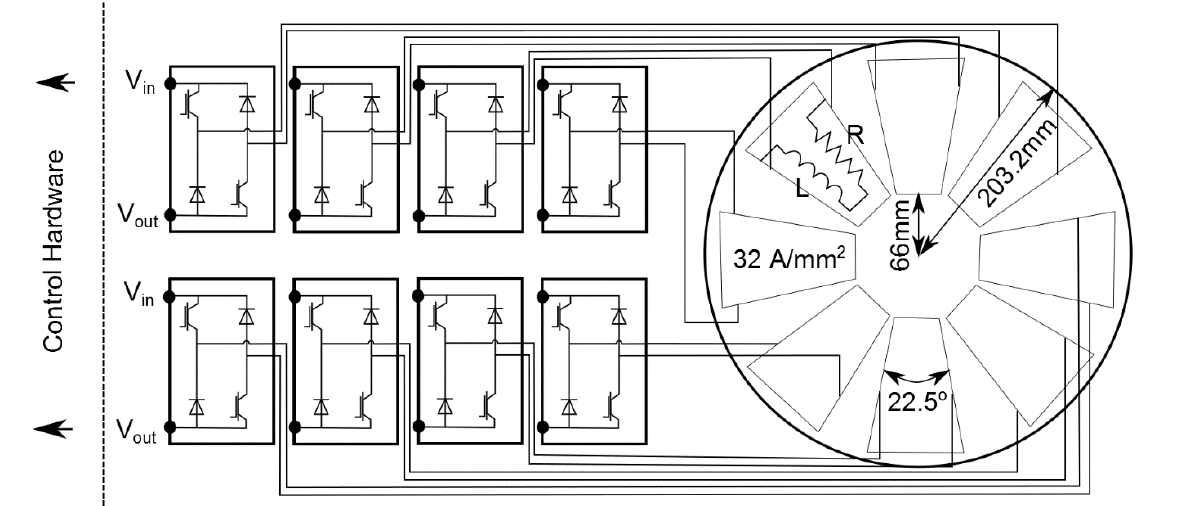
Figure 16. Specifications and wiring of the